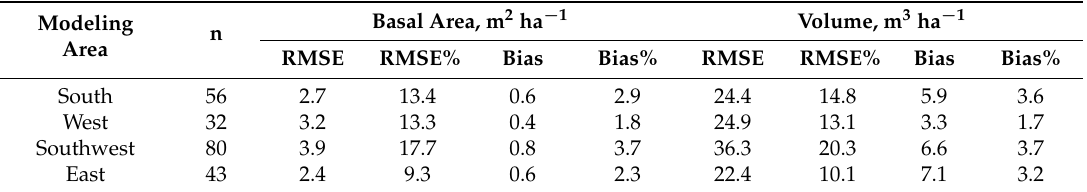
Table 7. Summary of compartment-level validation results. RMSE = root mean square error, RMSE% = error relative to mean value of compartments, n = number of plots used in validation.